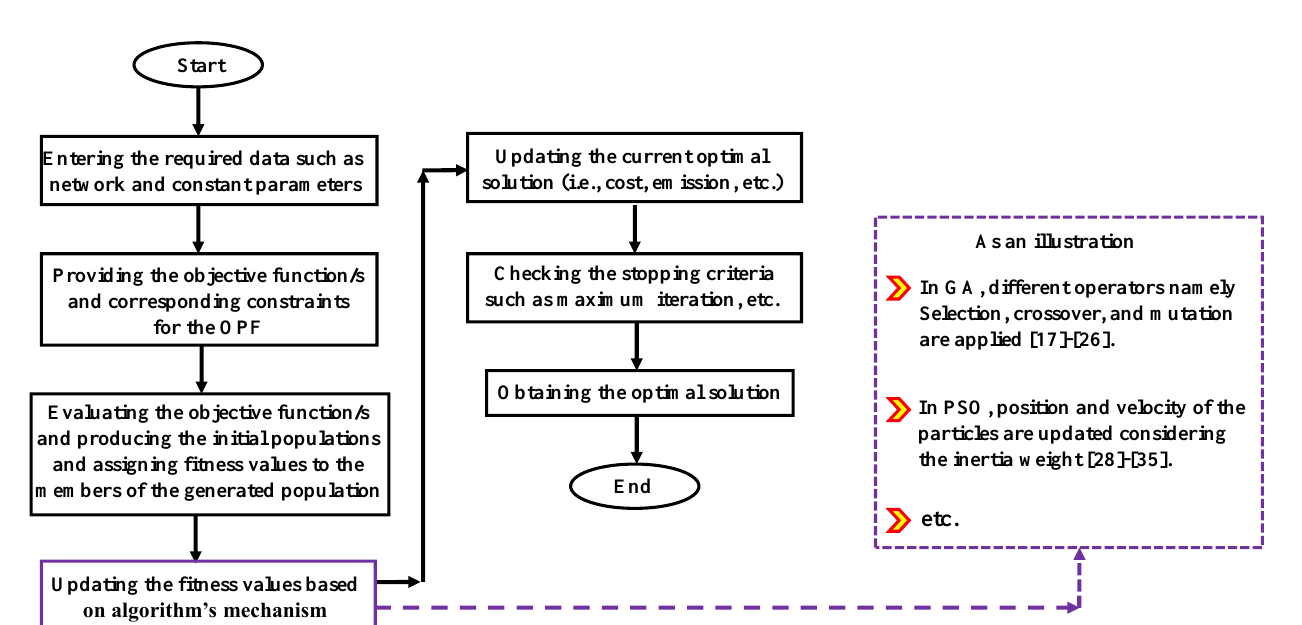
Figure 8. Flowchart associated with all of the reviewed optimization algorithms.